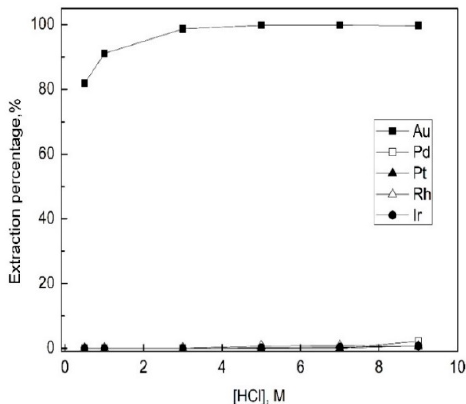
Figure 1. Effect of HCl concentration on the extraction of metals in a HCl solution containing Au(III), Pd(II), Pt(IV), Rh(III), and Ir(IV). ([HCl] = 0.5–9 M, [Cyanex 272] = 0.2 M, O/A = 1, [Au(III)] = [Pd(II)] =